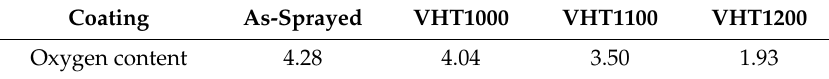
Figure 6. Microstructure of coatings after 21 h oxidation. ( a ) As-sprayed; ( b ) VHT1000; ( c ) VHT1100; and ( d ) VHT1200. Table 5. Oxygen content in the as-sprayed coating and VHT coatings (wt.%).